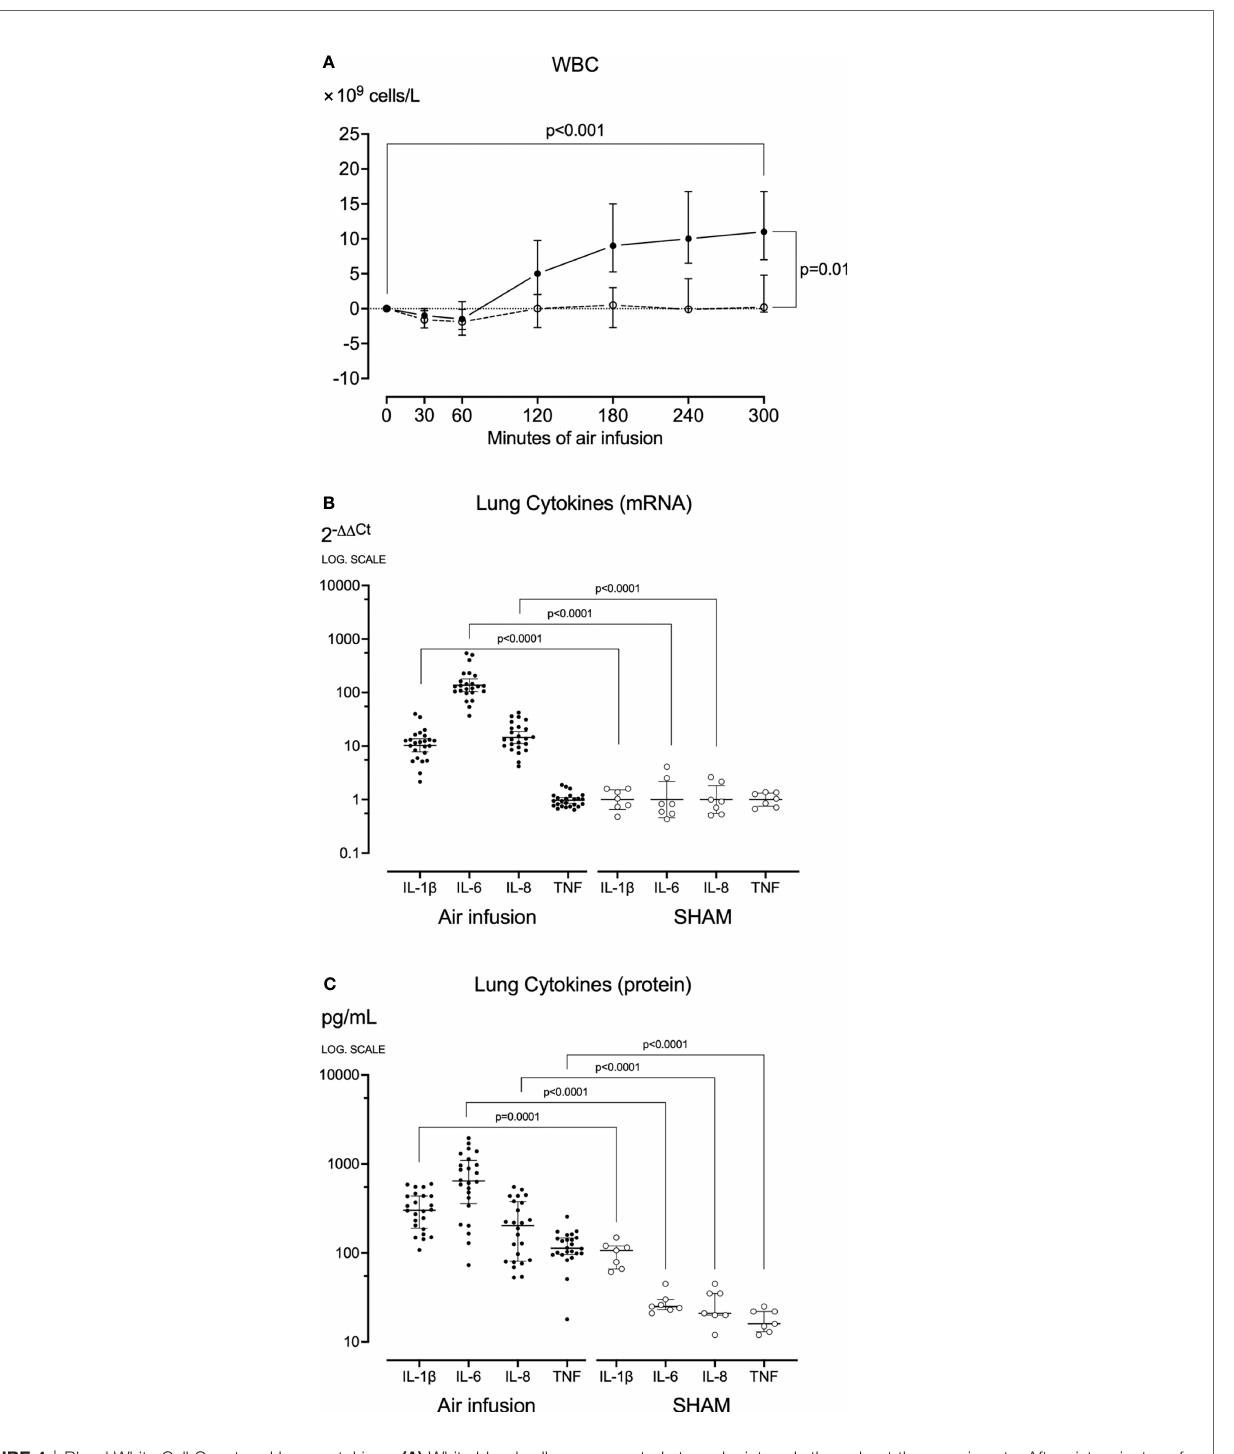
FIGURE 4 | Blood White Cell Count and Lung cytokines. (A) White blood cells were counted at regular intervals throughout the experiments. After sixty minutes of air infusion, white blood cells increased signi fi cantly from baseline in animals receiving air infusion (solid line) but not in sham animals (dotted line). (B) In lung tissue sampled post-mortem cytokine mRNA was analyzed using qPCR, and results were calculated using the 2 - DD Ct method. (C) In lung tissue sampled post-mortem, cytokines were measured using ELISA or multiplex. Animals receiving air infusion are represented as closed circles and solid lines, and sham animals as open circles and dotted lines. Circles in panel (A) and horizontal lines in panel (C) represent medians, and error bars span the interquartile range. The horizontal lines in panel (B) represent the geometric means, and error bars span the 95% CI of the